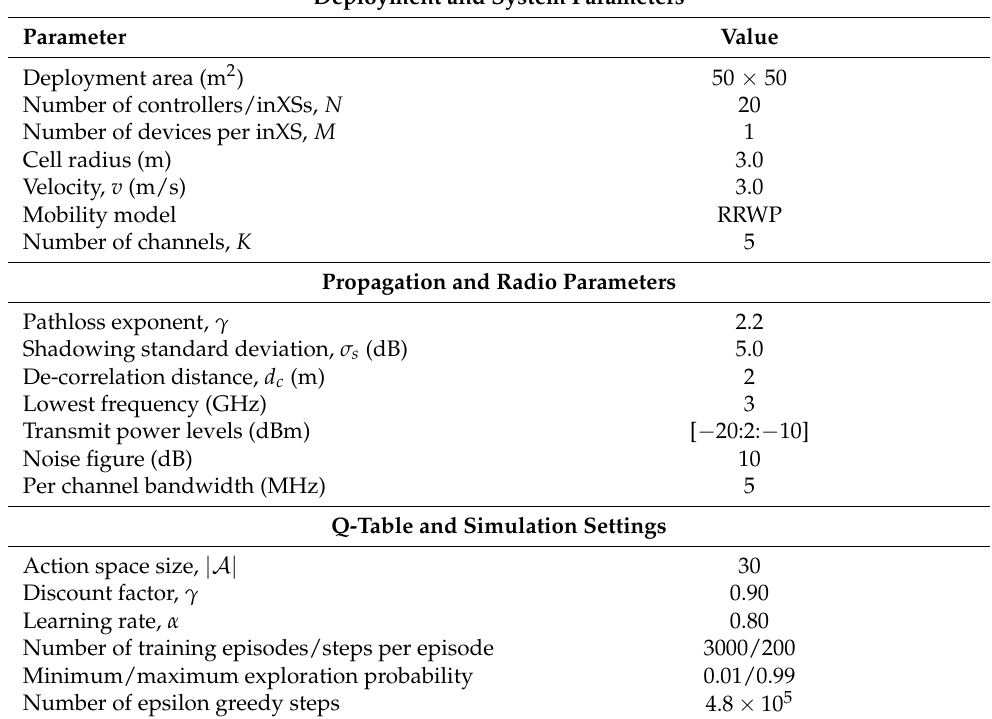
Table 1. Simulation